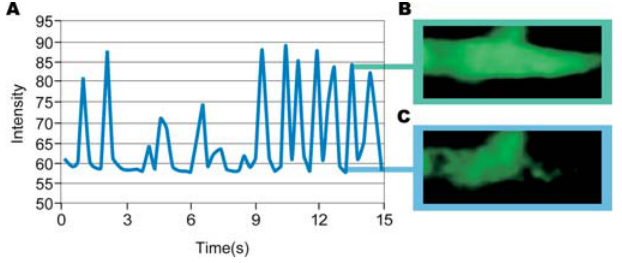
Figure 5. Measuring Calcium Transient Frequency Graphical representation of the calcium transient in a beating CPS cell–derived cardiomyocyte (A). Fluorescent intensity is proportional to the amount of calcium binding to fluo-3 dye upon release of calcium from the sarcoplasmic reticulum. Peak intensity (B) and baseline (C) are shown. DOI: